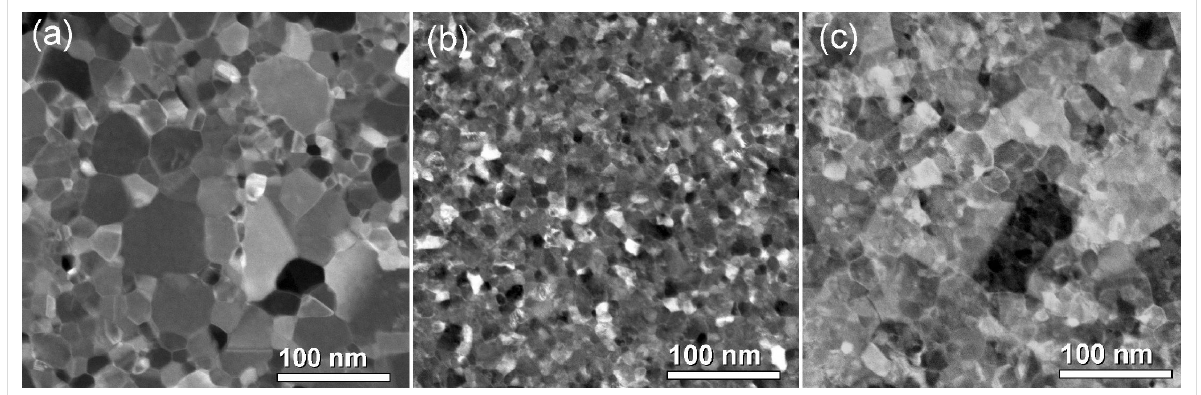
Figure 5: Bright-field STEM images obtained within different regions of the forming-free device: (a) top electrode, (b) bottom electrode, and (c) junction.